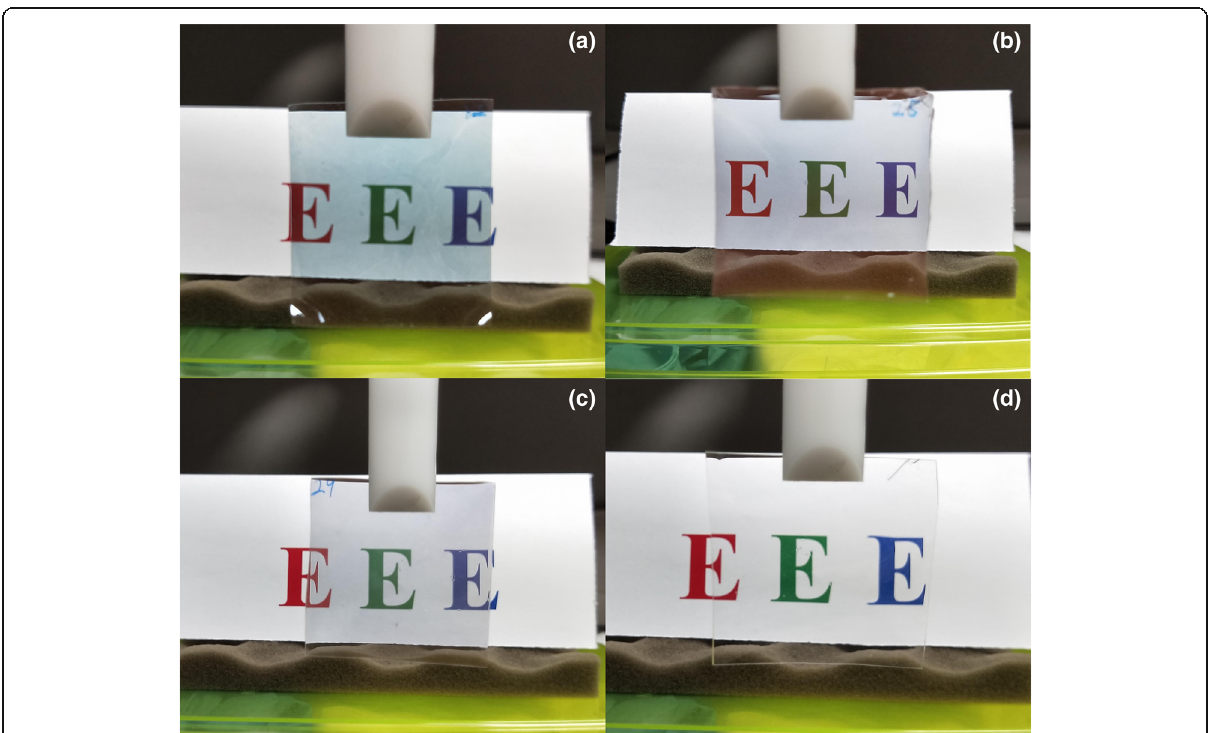
Fig. 5 a Film dispersed with the 16-nm gold nanoshell. b Film dispersed with the 29-nm gold nanoshell. c Film dispersed with the 36-nm gold nanoshell. d Pure PVA